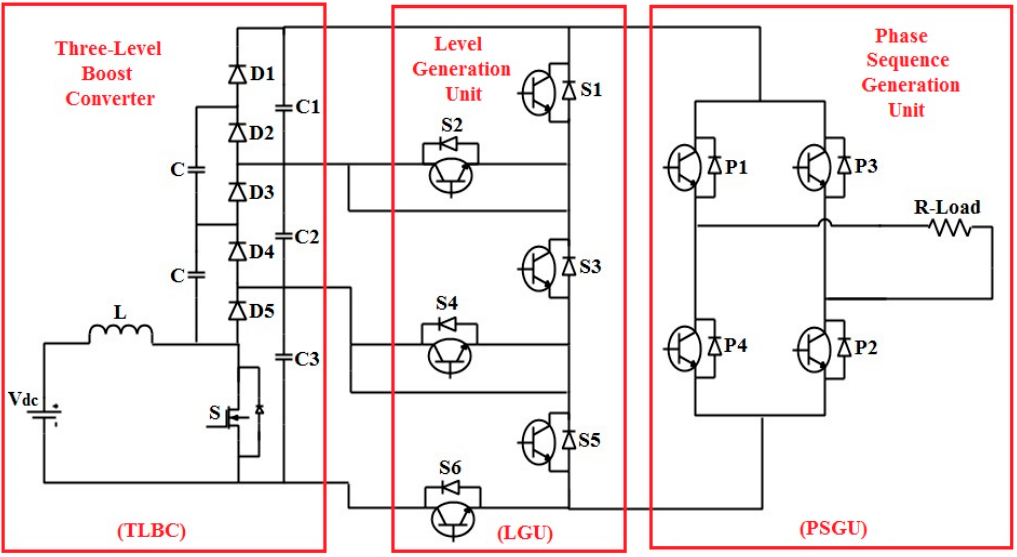
Figure 2. Equivalent structure of TLBDCLCHB MLI system.